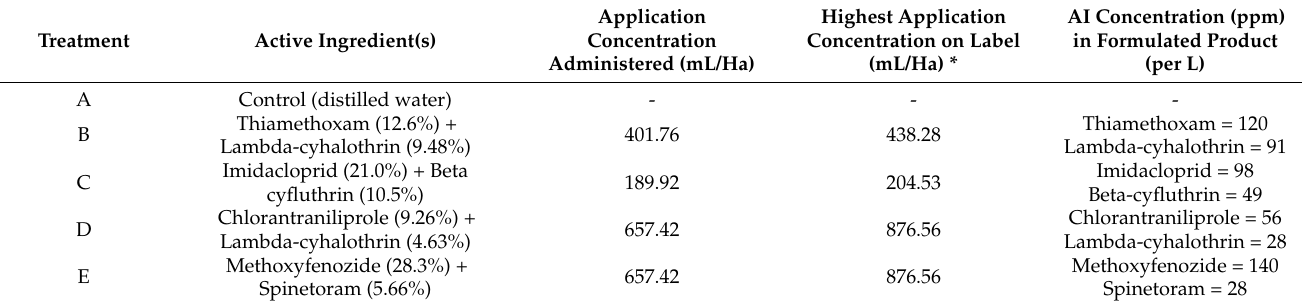
Table 2. Application concentration administered by spray application, highest recommended application concentration, and active ingredient concentrations of formulated premix insecticides assessed for acute whole-body contact toxicity to adult male (Experiment 1) and female (Experiment 2) Osmia lignaria